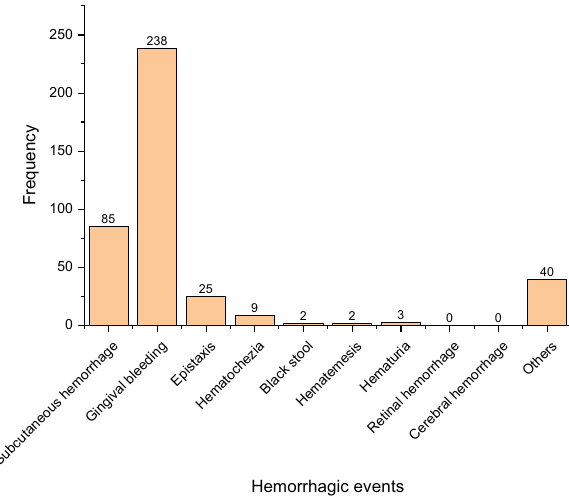
Figure 3. Frequency of hemorrhagic events in positive individuals.